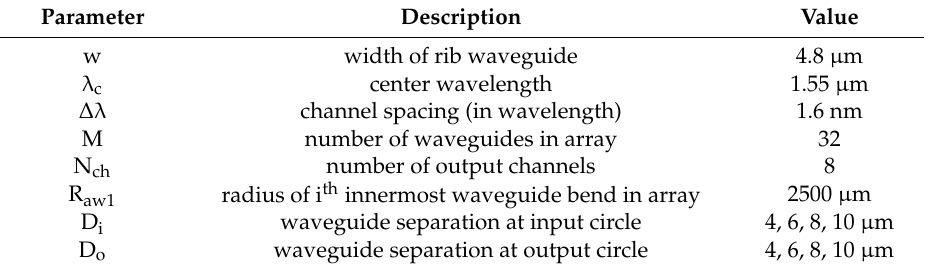
Table 1. The designed parameters and values for silicon arrayed-waveguide grating (AWG).